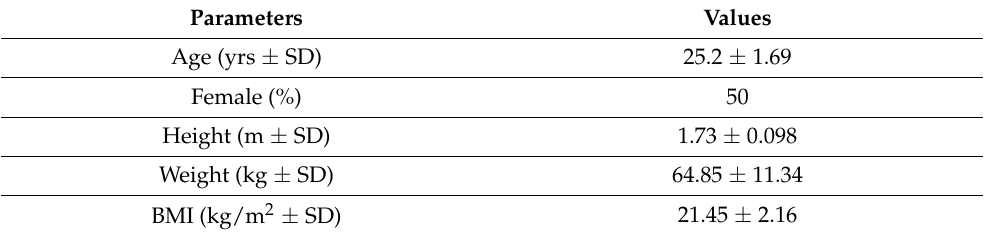
Table 2. Mean anthropometrical parameters of participants at